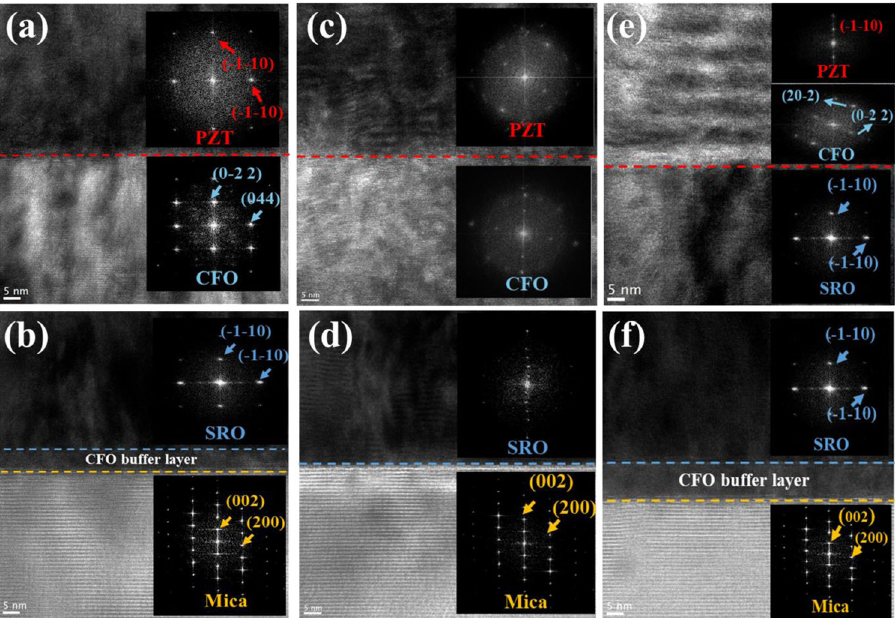
Fig. 2 The cross-sectional TEM images with the FFT diffraction patterns and the EDS mapping of three structures. The TEM images with the FFT diffraction patterns of a , b epitaxial, c , d polycrystalline, and e, f nanostructure